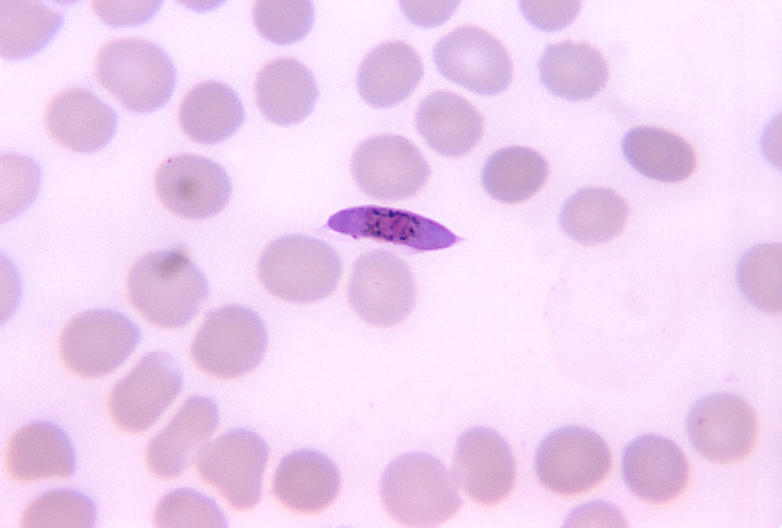
Mosquitoes are most attracted to children infected with malarial parasites in the gametocyte stage (pictured above). The Anopheles mosquito ingests gametocytes during its blood meal. (CDC/ Dr. Mae Melvin)